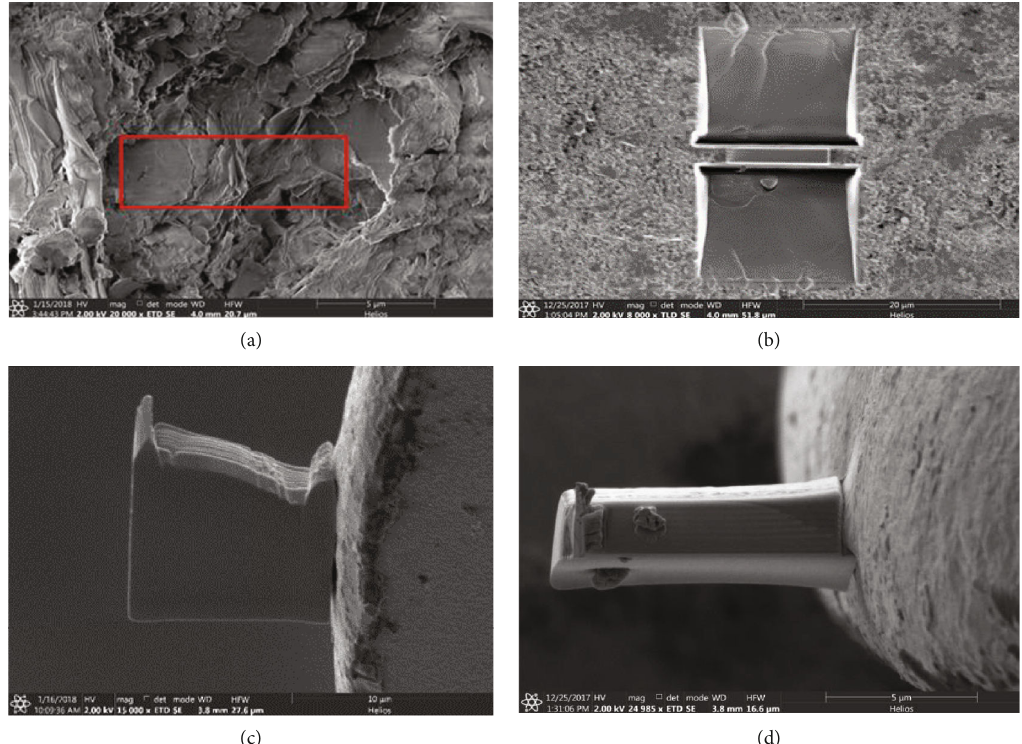
Figure 3: Sample preparation process. (a) Selection of a suitable area under SEM. (b) Cutting the selected area. (c) Thinning the sample. (d) Fixing the